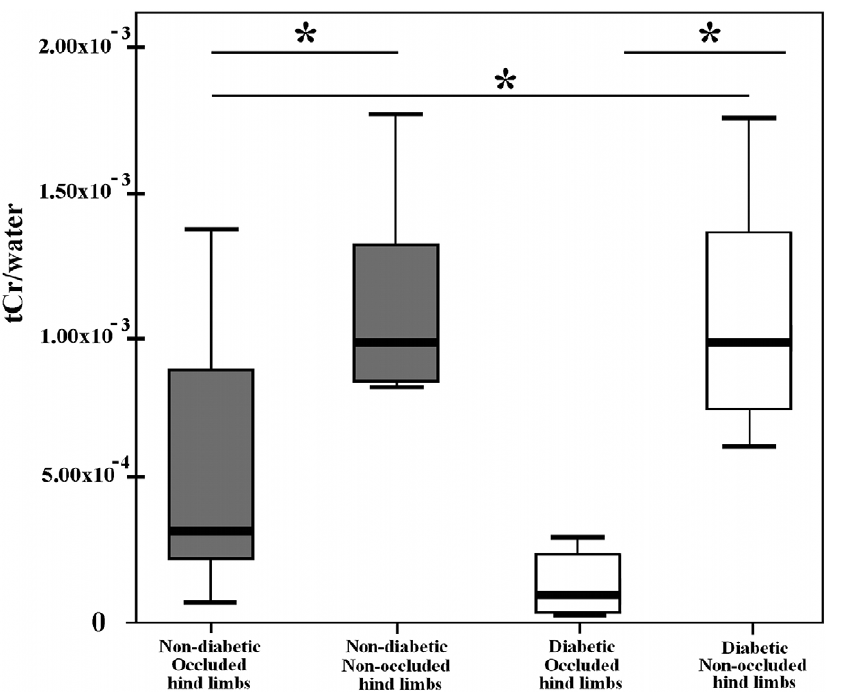
Figure 6. Box and Whiskers plot depicting tCr/water levels between occluded and non-occluded limbs for each groups. Values of tCr/ water for occluded limb were significantly lower than non-occluded limbs in both non-diabetic (n=6, * p , 0.05) and in diabetic rats (n=7, * p , 0.05). Values of tCr/water occluded limbs were significantly lower in diabetic compared with non-diabetic (* p , 0.05).